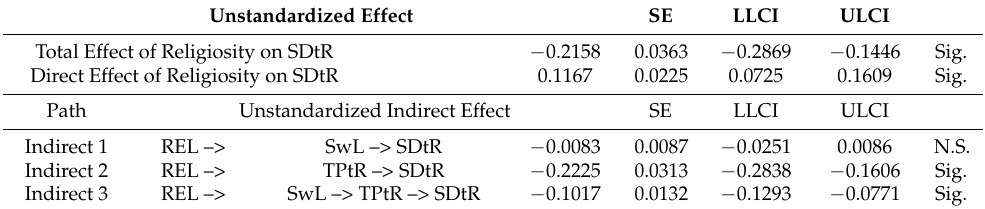
Table 5. Indirect effects of religiosity on